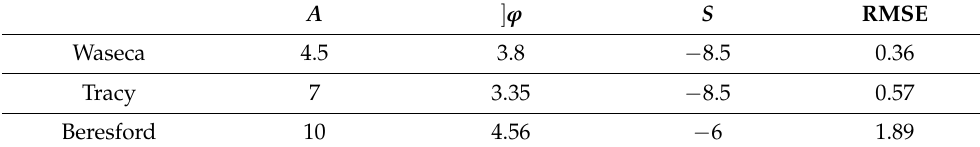
Table 4. Input function sine wave parameters and the root mean square errors (RMSE).